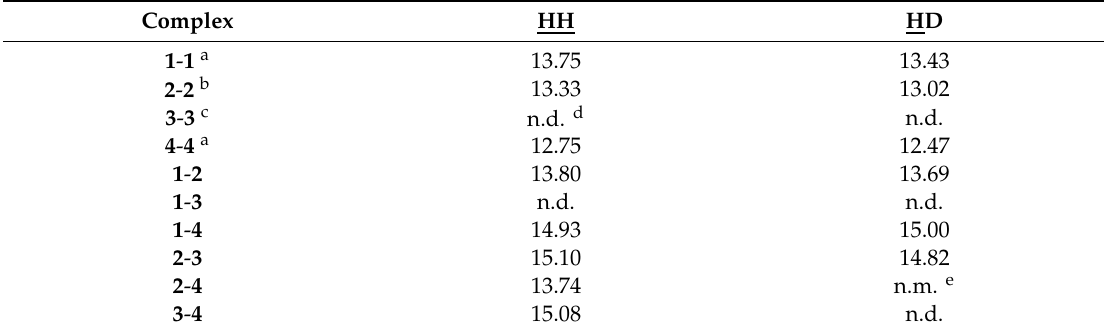
Figure 5. The low-field part of 1 H - NMR spectrum of the sample containing acids 1 and 3 (1.2:1) in CDF 3 /CDF 2 Cl at 100 K. The experimental spectrum is deconvoluted into the sub-spectra arising from self-associated of 1 or 3 , heterodimer 1 - 3 , two heterotrimers, 1 - 3 - 1 and 3 - 1 - 3 , and a tetramer, consisting of two molecules of 1 and two molecules of 3 in a cyclic 1 - 3 - 3 - 1 configuration. For visual clarification the signals in the experimental spectrum and the computed sub-spectra are color coded. Trimers and tetramers are marked by asterisks and squares, respectively.